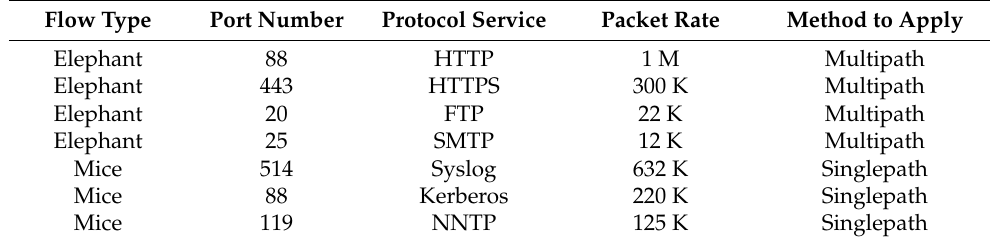
Table 2. Routing Traffic Based on Flow Types.